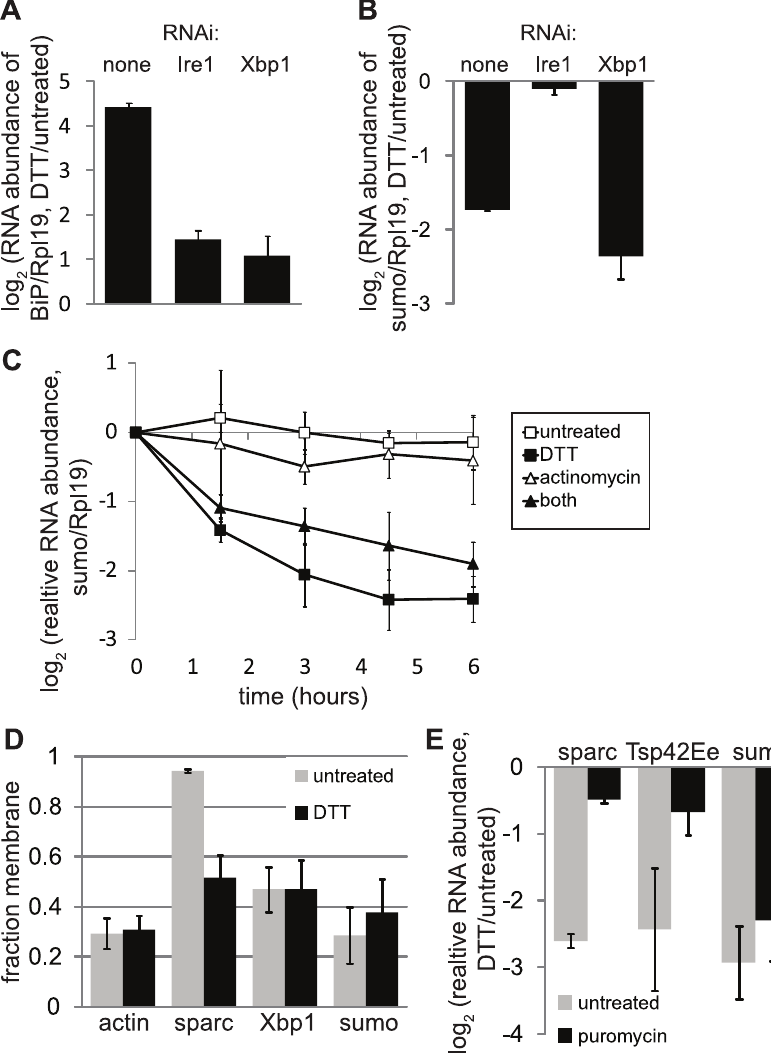
Figure 1. Sumo mRNA is a non-canonical RIDD target. For all panels, we measured relative RNA abundance by qPCR; shown are the averages and SDs of 3-4 independent experiments. Except for the fractionation in panel D, we normalized all mRNA abundance measurements to the housekeeping control Rpl19. A-B. Relative mRNA levels of BiP (panel A) and sumo (panel B) in mock-treated and Ire1- or Xbp1-depleted Drosophila S2 cells incubated in the absence and presence of ER stress (2 mM DTT, 4.5 hours). Xbp1 transcript levels in the Xbp1 RNAi-treated cells were 13.5% + / 2 0.9% of the levels in control cells, as measured by qPCR. C. Timecourse of sumo mRNA levels in S2 cells treated with or without actinomycin D (1 m g/ mL) to block transcription and DTT (2 mM) to induce ER stress. D. Fraction membrane (membrane/total) for mRNAs from S2 cells treated with and without DTT (2 mM, 20 min). We separated cytosolic and membrane RNAs using detergent extraction (see Materials and Methods). E. Relative mRNA levels in cells treated with or without 35 m M puromycin (added 10 min prior to stress) and DTT (2 mM, 4